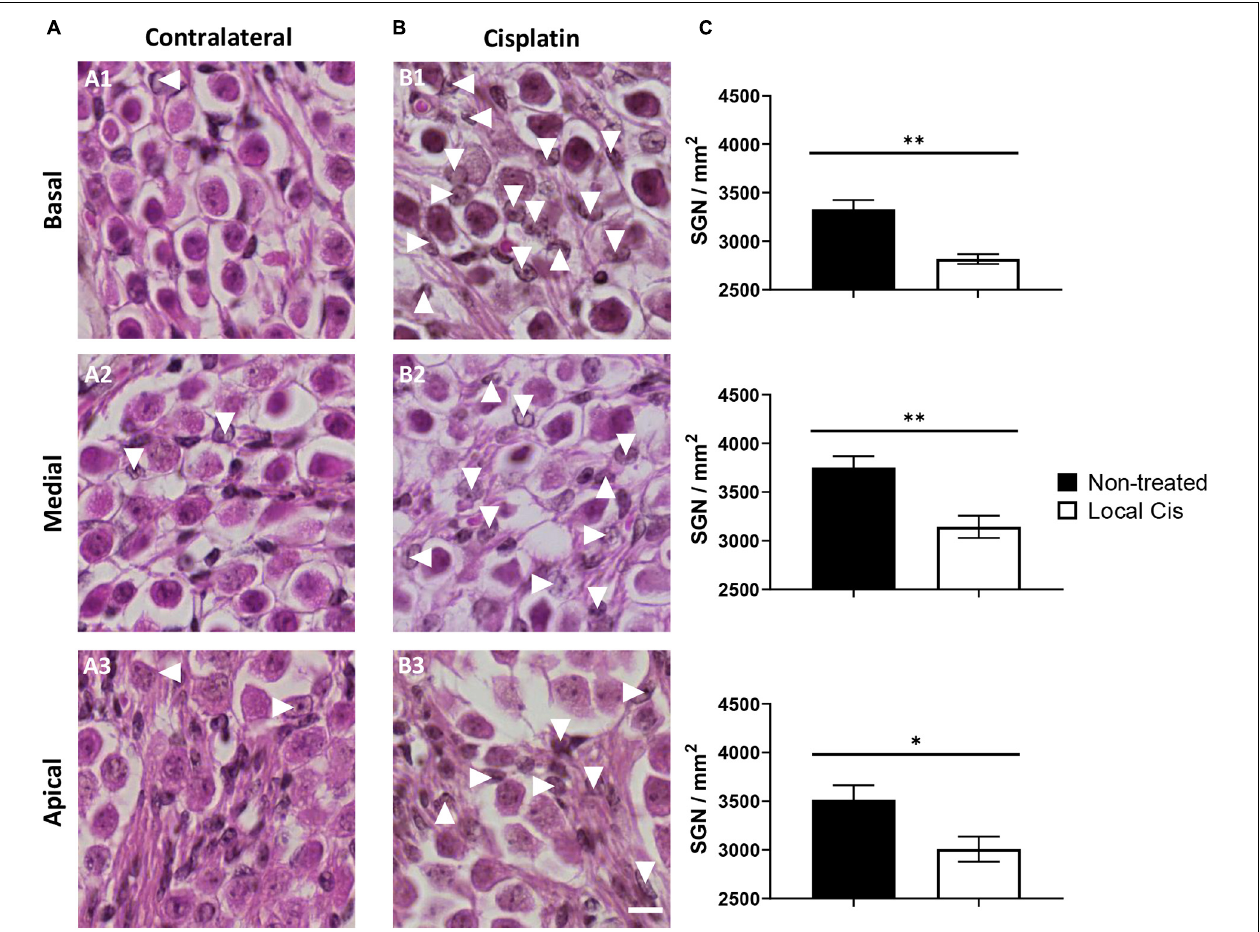
FIGURE 3 | Local delivery of cisplatin effect on auditory neuron viability. (A,B) Mid-modiolar histology of mouse cochlea treated with local-cisplatin (5 mM) (B) or contralateral cochlea (A) showing spiral ganglion. Spiral ganglion neurons in basal (A1,B1) , medial (A2,B2) , and apical (A3,B3) turns were quantified and normalized with size of counting area (in square millimeter). (C) Bar graph showing density of auditory neurons. Arrows indicate apoptotic or missing auditory neurons (without subgroup distinction). Scale bar: 10 µ m. n = 15. The confidence interval for both statistics was set as 95% ( a = 0.05); ∗ p < 0.05; ∗∗ p < 0.01.